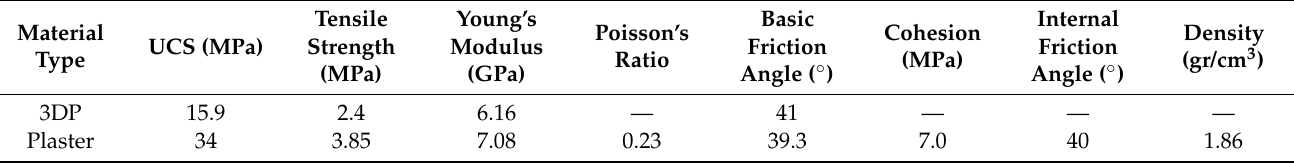
Table 1. Mechanical properties of 3DP and plaster